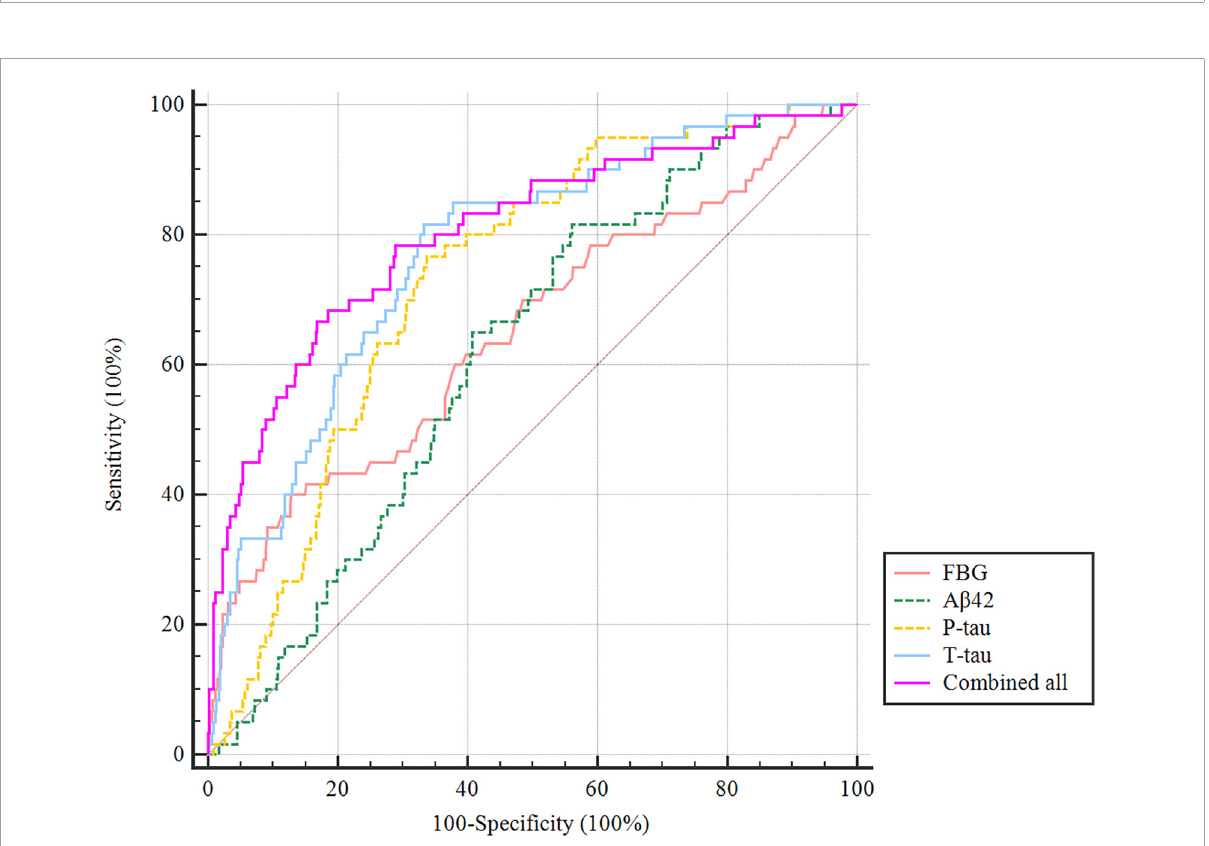
FIGURE5 Predictive model. ROC curve showing the levels of FBG (AUC = 0.652; P < 0.001), CSF A β 42 (AUC = 0.619; P < 0.001), P-tau (AUC = 0.733; P < 0.001), and T-tau (AUC = 0.773; P < 0.001) exhibited a discriminatory ability in POD prediction. POD, postoperative